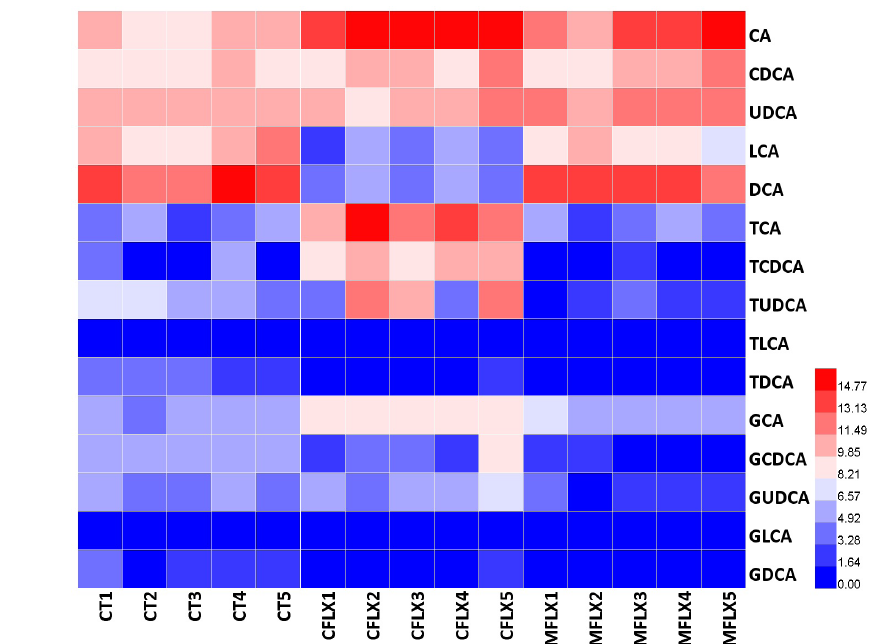
FIGURE 3 - Heatmap of the effect of ciprofloxacin and moxifloxacin on host BA profiles in the large intestine of normal rats treated with 100 mg/kg/day ciprofloxacin and 40 mg/kg/day of moxifloxacin orally for seven days. The heatmap was generated using HemI 1.0.3.7. Red indicates an increased value, whereas blue indicates a decreased